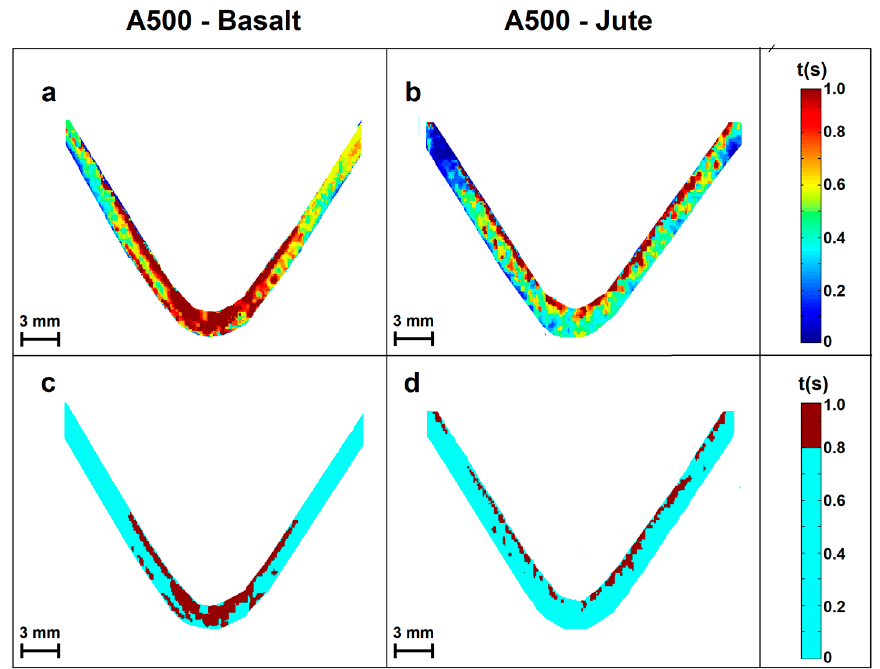
Figure 5. TRMs calculated for two specimens: A500-Basalt ( a ) and A500-Jute ( b ). The area of the two specimens characterized by recovery times longer than 0.8 s are shown in dark red in ( c ) and in ( d ). Both maps highlight areas of the specimens characterized by di ff erent recovery times.